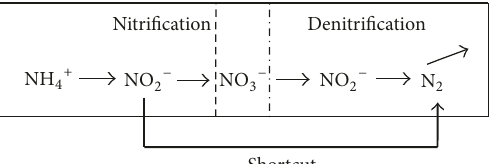
Figure 1: Biological nitrogen removal by nitrification-denitrifica-